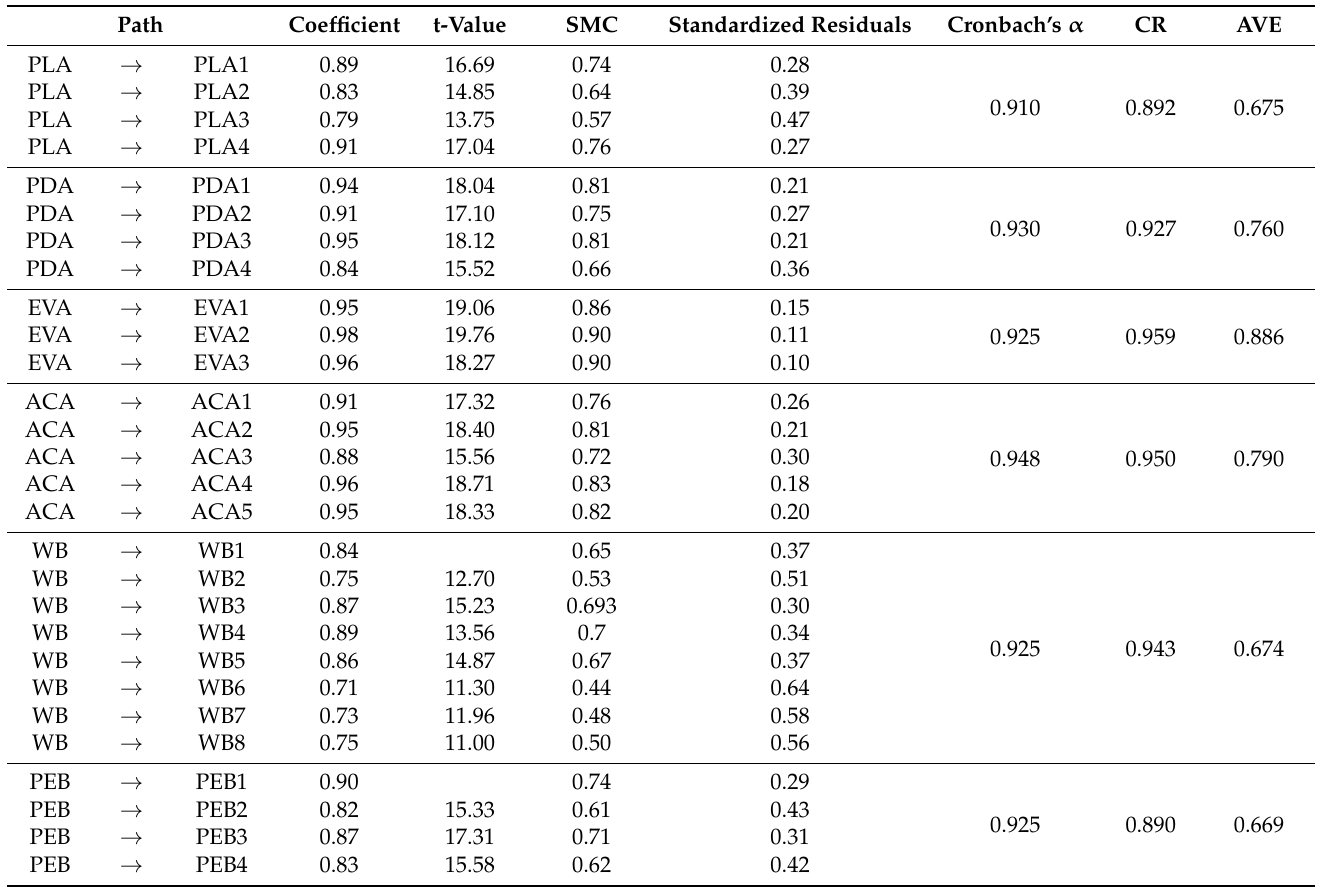
Table 2. Result of the confirmatory factor